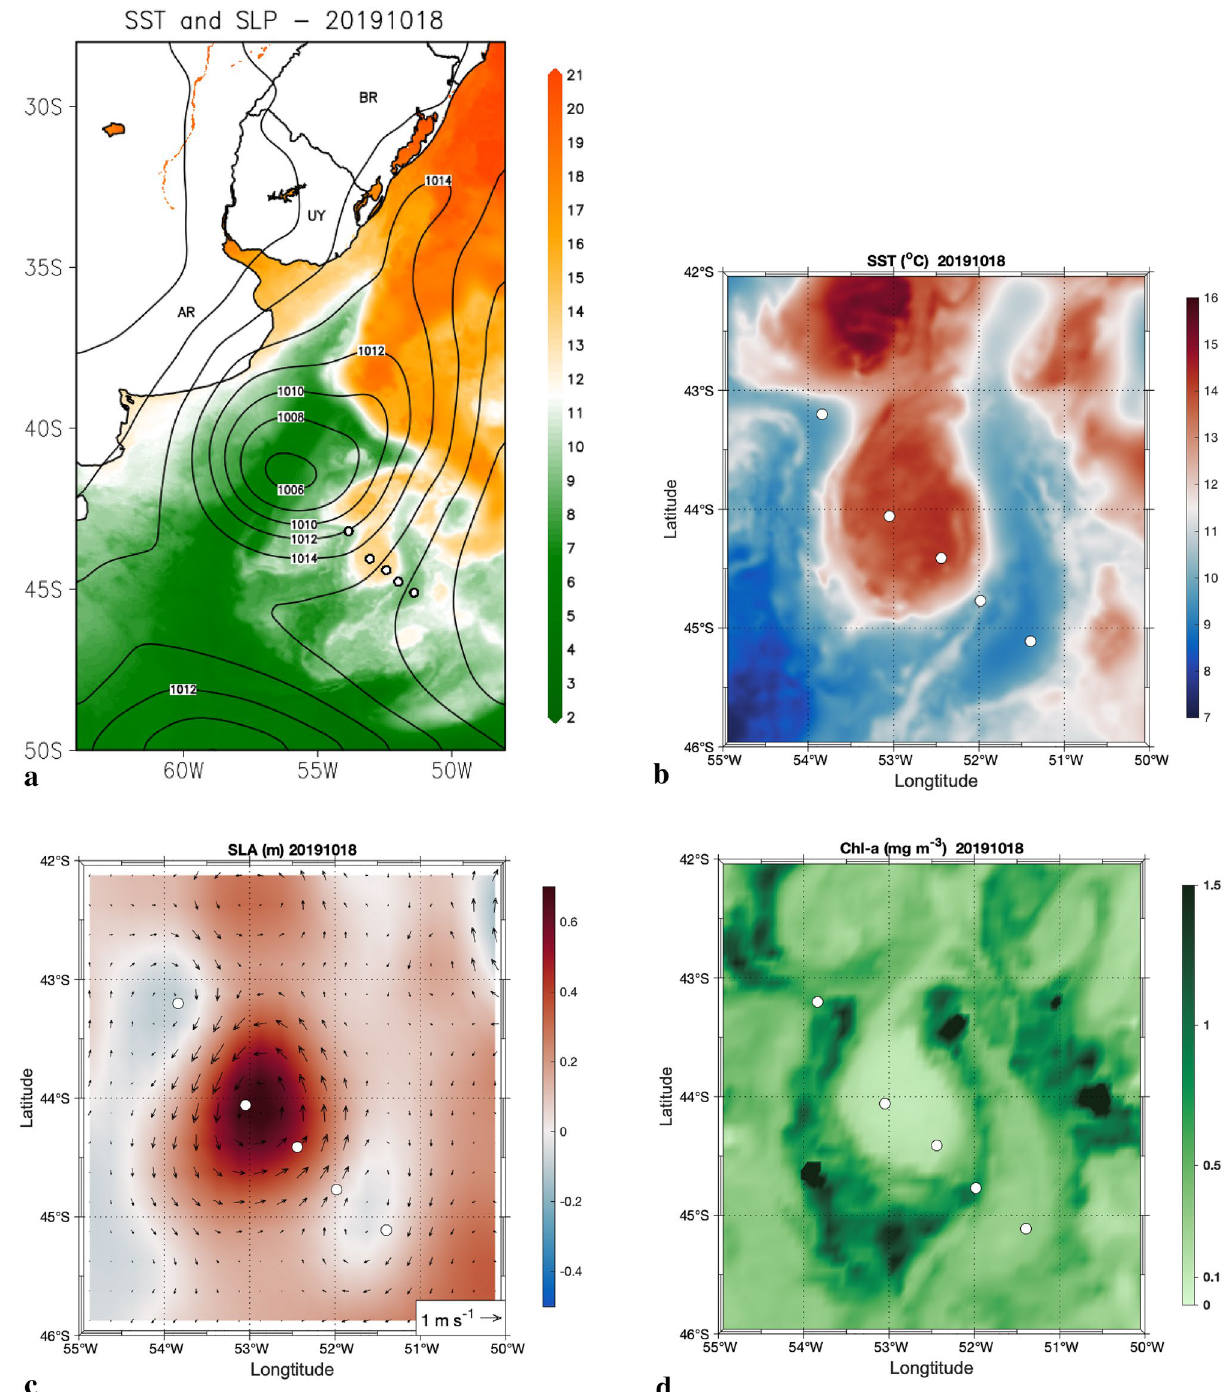
Figure 1. Images showing Southwestern Atlantic Ocean and study area. (a) MUR Sea Surface Temperature (°C) with Reanalysis ERA5 Sea Level Pressure (hPa) showing the study area in a broad view. (b) Same as (a) , but in view zoom of the eddy. (c) Sea Level Anomaly (m) relative to the geoid measured by Altimetry (colors) and derived absolute geostrophic velocity current vectors (m s -1 ). (d) Chlorophyll-a concentration (Chl-a in mg m −3 ). All data are for 18th October 2019. The white circles denote the Po/V Almirante Maximiano trajectory while crossing the eddy dipole and the XBTs and radiosondes launching positions. The symbols over the continent indicate the country names of Brazil (BR), Uruguay (UY) and Argentina (AR). Grid Analysis and Display System (GrADS), Version 2.2.1.oga.1. http:// openg rads. org. MATLAB, Version 9.1.0.441655 (R2016b). https:// www. mathw orks.